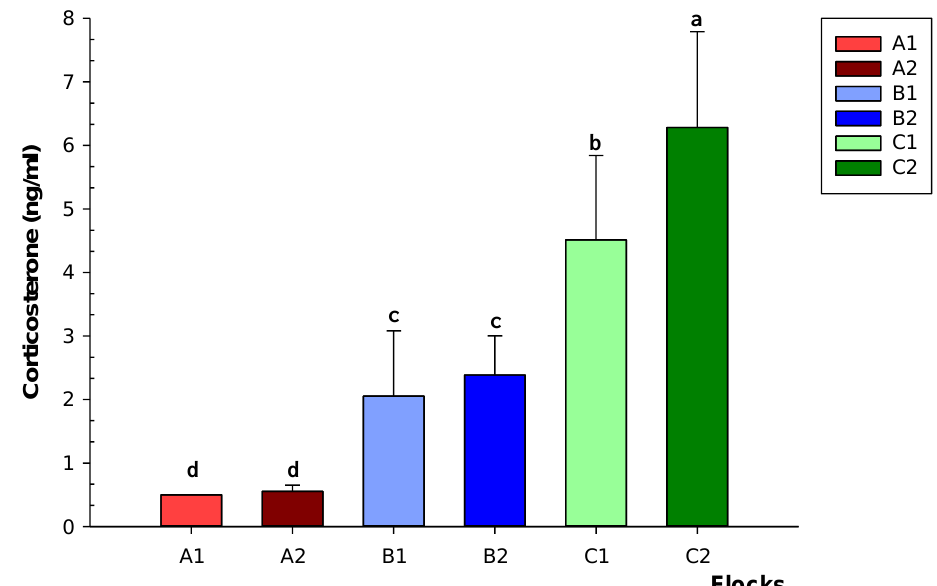
Figure 3. Levels of corticosterone in flocks of laying hens housed in enriched cages (A1–A2), barns (B1–B2) and aviaries (C1–C2). Data are reported as means ± standard deviations. Different letters (a – d) indicate significant differences ( p < 0.05) among the different flocks of birds.